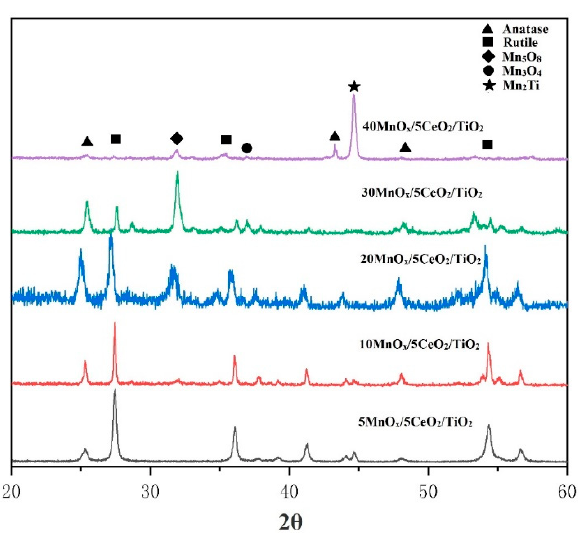
Figure 4. XRD of the initial powder.